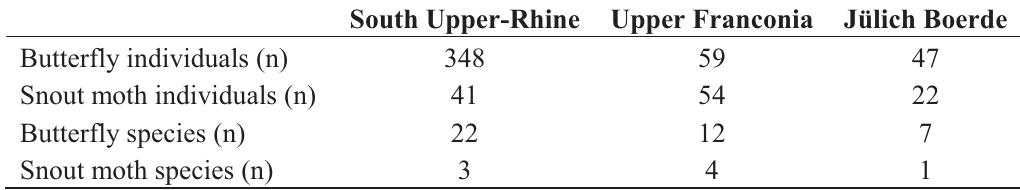
Table 4. Species and abundance of Crambid Snout Moths recorded by the transect